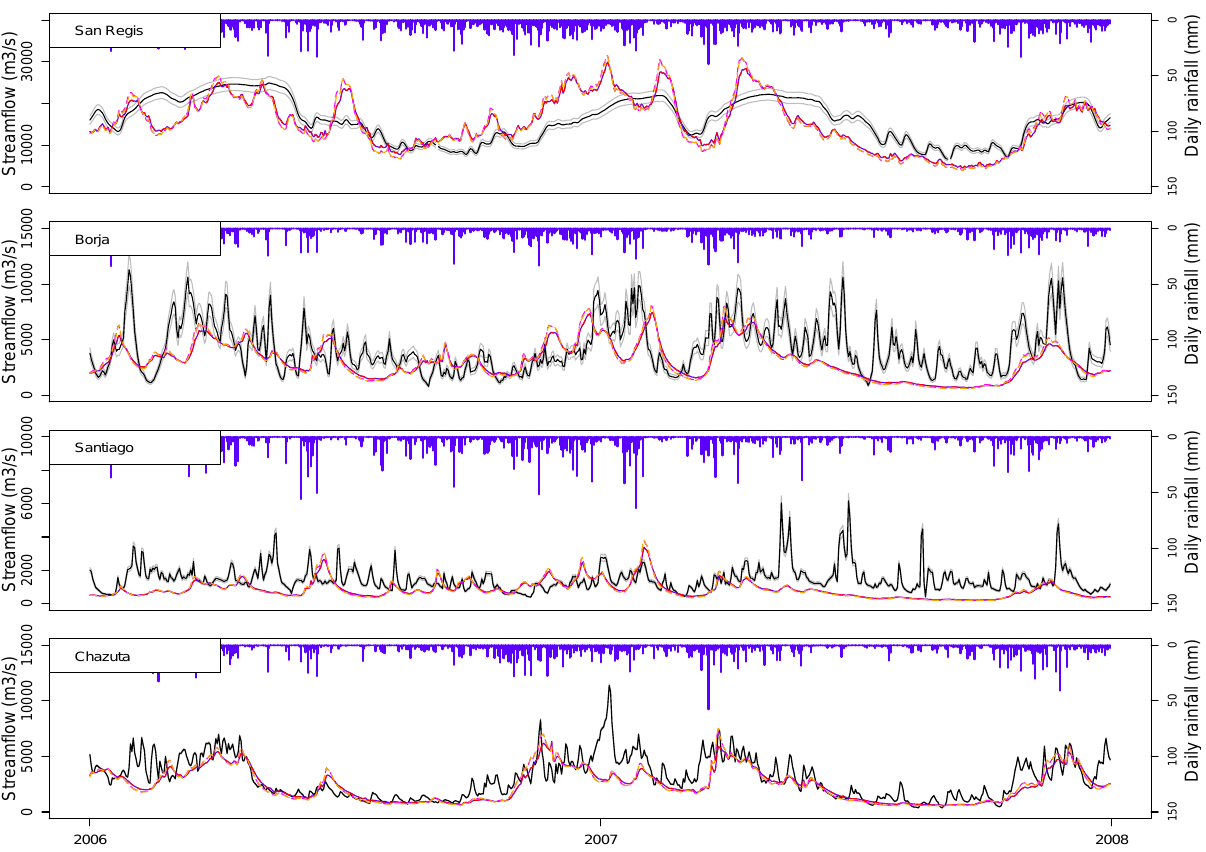
Fig. 9. The model (TRMM-JULES BASE) sensitivity to variations in the soil parameters. Blue: tropical PTF – stratified, magenta: tropical PTF-homogeneous, red: temperate PTF – stratified, orange: temperate PTF – homogeneous, black: observed, gray: 95% confidence interval.